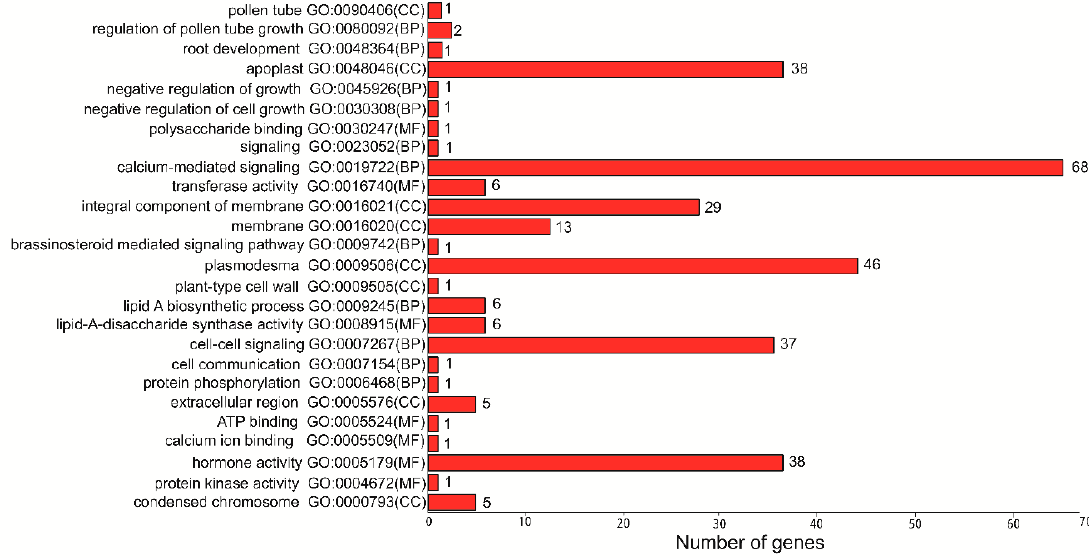
Figure 5. The gene ontology (GO) term distribution and functional clustering among seven Rosaceae species.